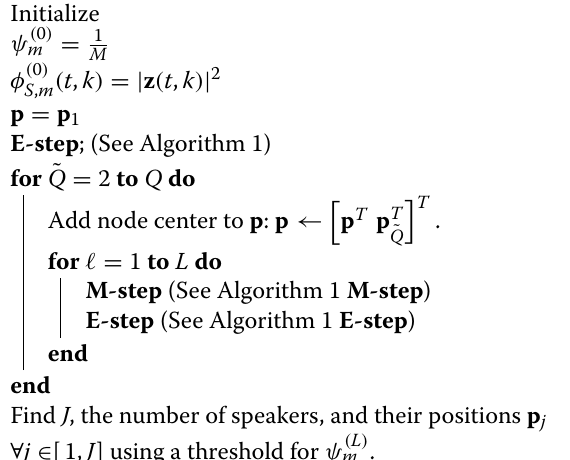
Algorithm 2: LACES algorithm for noisy environ- ments.